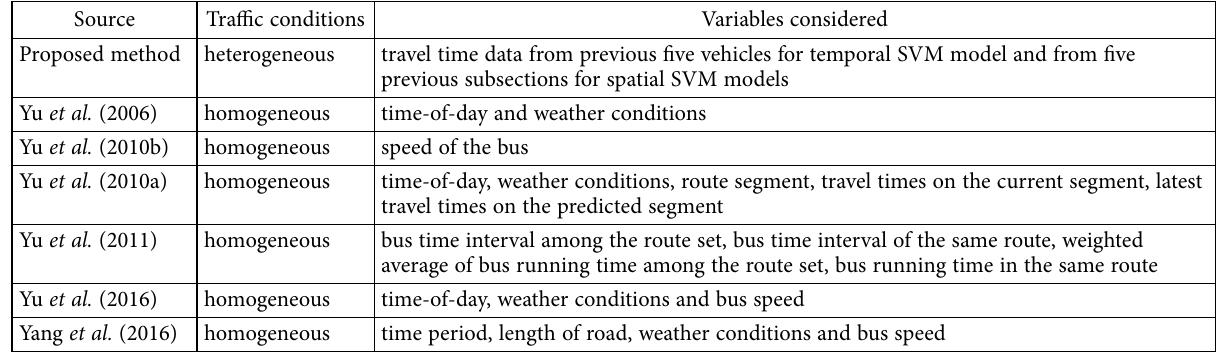
Table 1. Summary of literature that used SVM for bus travel time